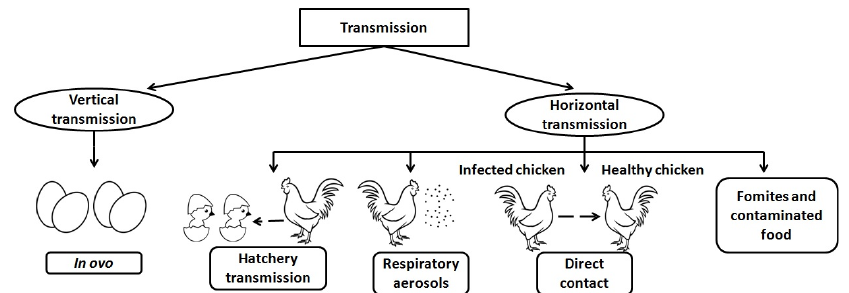
Figure 2. M odes of transmission of Mycoplasma gallisepticum